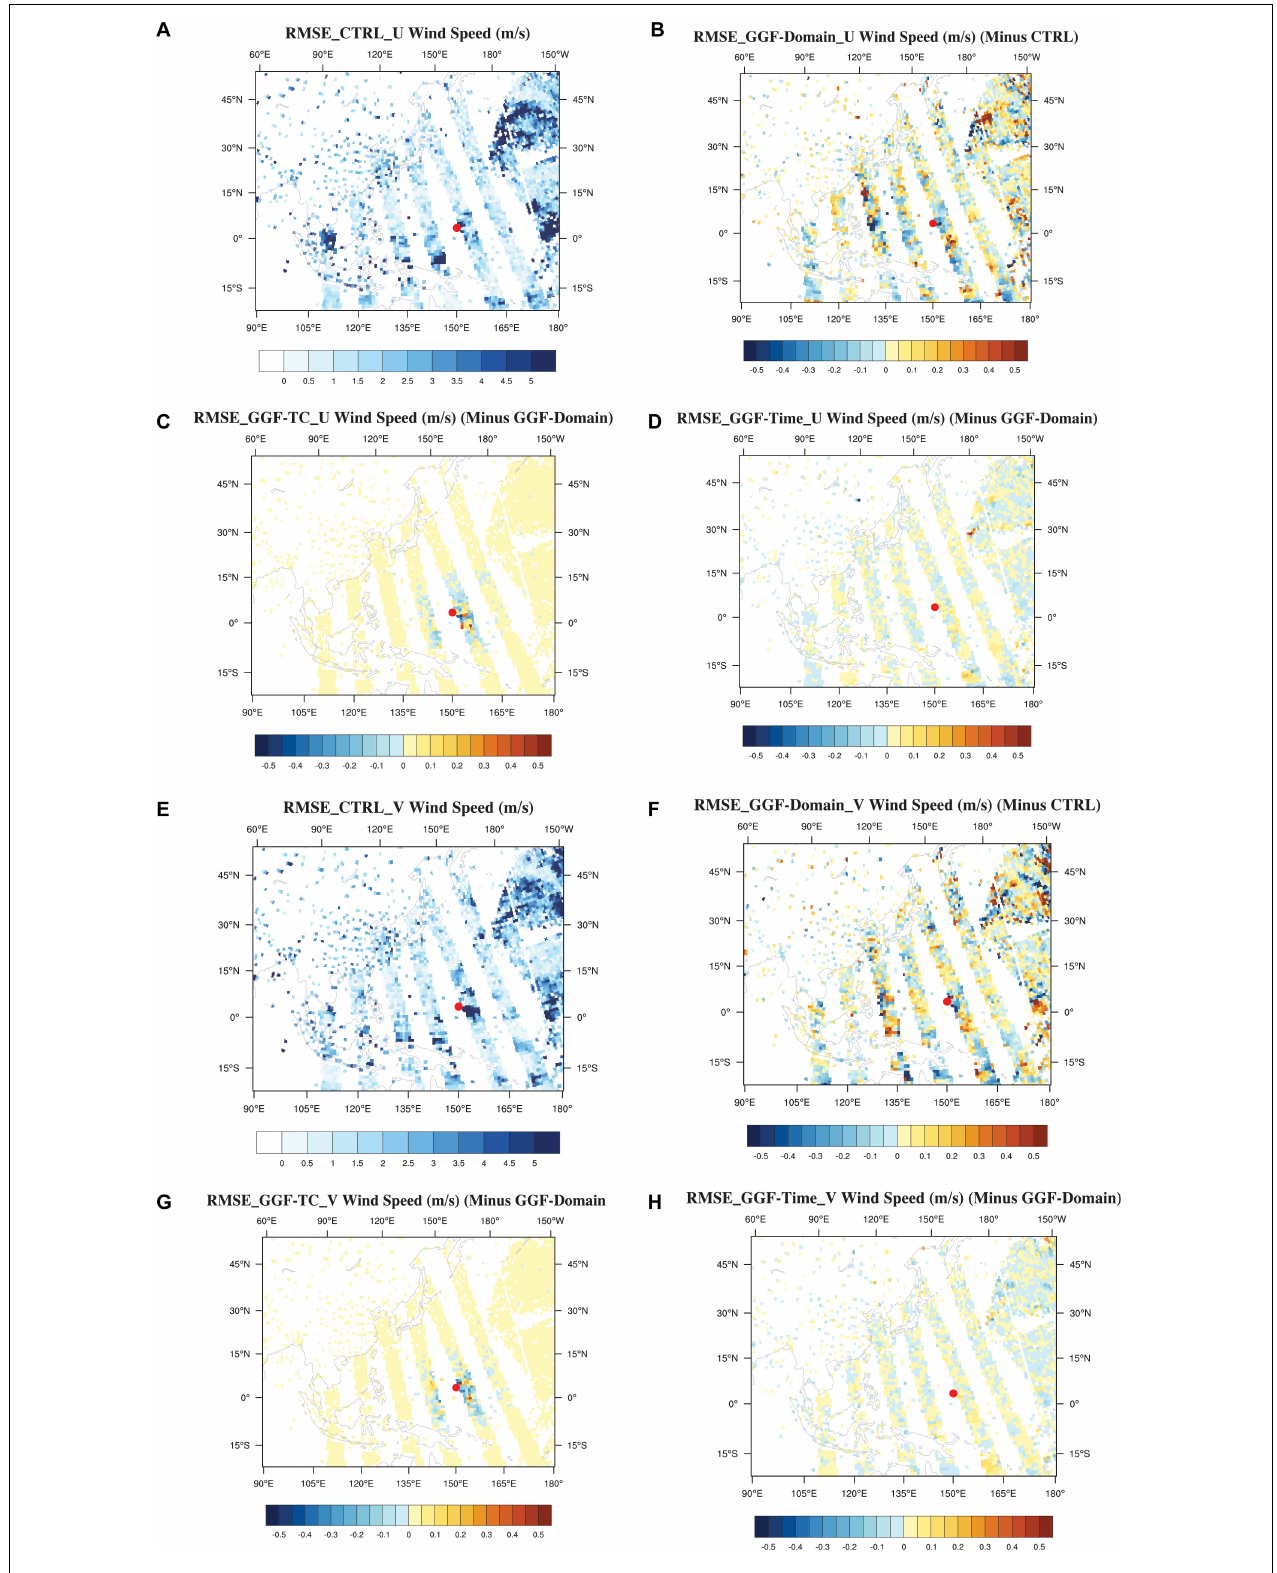
FIGURE 7 | Vertically averaged analysis errors of (A) u- and (E) v-winds from experiment CTRL, analysis error differences between experiments GGF-Domain and CTRL for (B) u- and (F) v-winds, and analysis error differences between experiments GGF-TC (GGF-Time) and GGF-Domain for (C)((D)) u- and (G)((H)) v- winds.